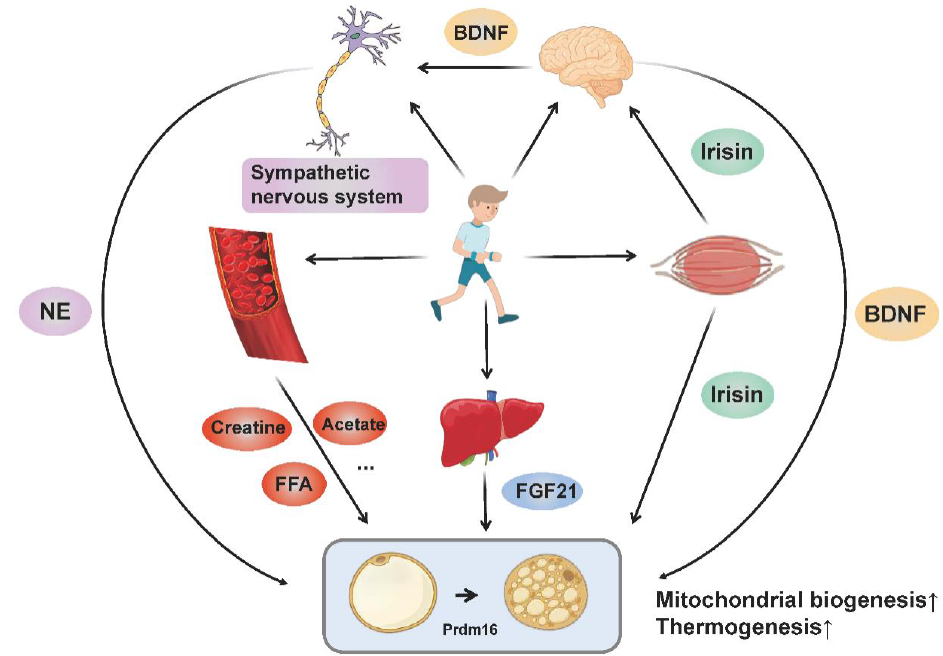
Figure 2. The molecular networks by which exercise promotes adipose tissue browning and thermogenesis. Exercise stimulates sympathetic excitation and releases norepinephrine binding to β -adrenergic receptors to promote adipose tissue thermogenesis and browning. In addition, exercise promotes the muscular release of irisin and hepatic release of FGF21. Irisin not only regulates the browning of adipocytes directly, but also promotes the release of BDNF from the brain through “muscle-brain crosstalk” and thus increases adipose tissue thermogenesis and browning. BDNF also acts on the sympathetic nervous system to mediate WAT browning. Circulating metabolites (such as creatine, acetate and FFA) produced by exercise also enhance adipose tissue thermogenesis and browning directly or indirectly. All these pathways ultimately target thermogenic gene expression and mitochondrial